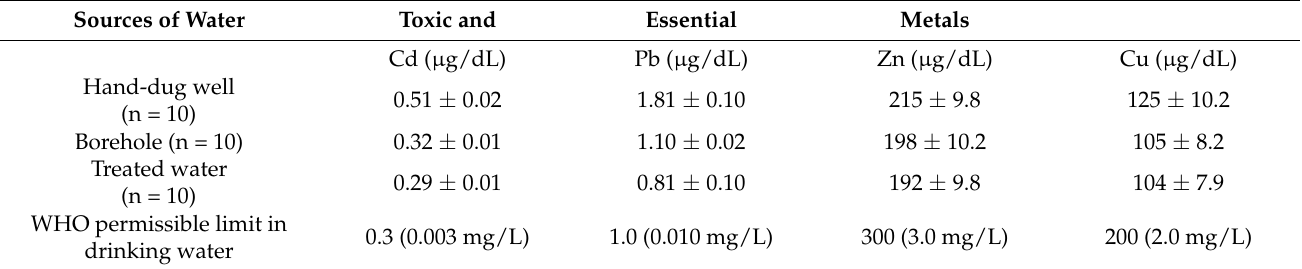
Table 2. Toxic and essential metal concentrations in hand-dug well, borehole and treated